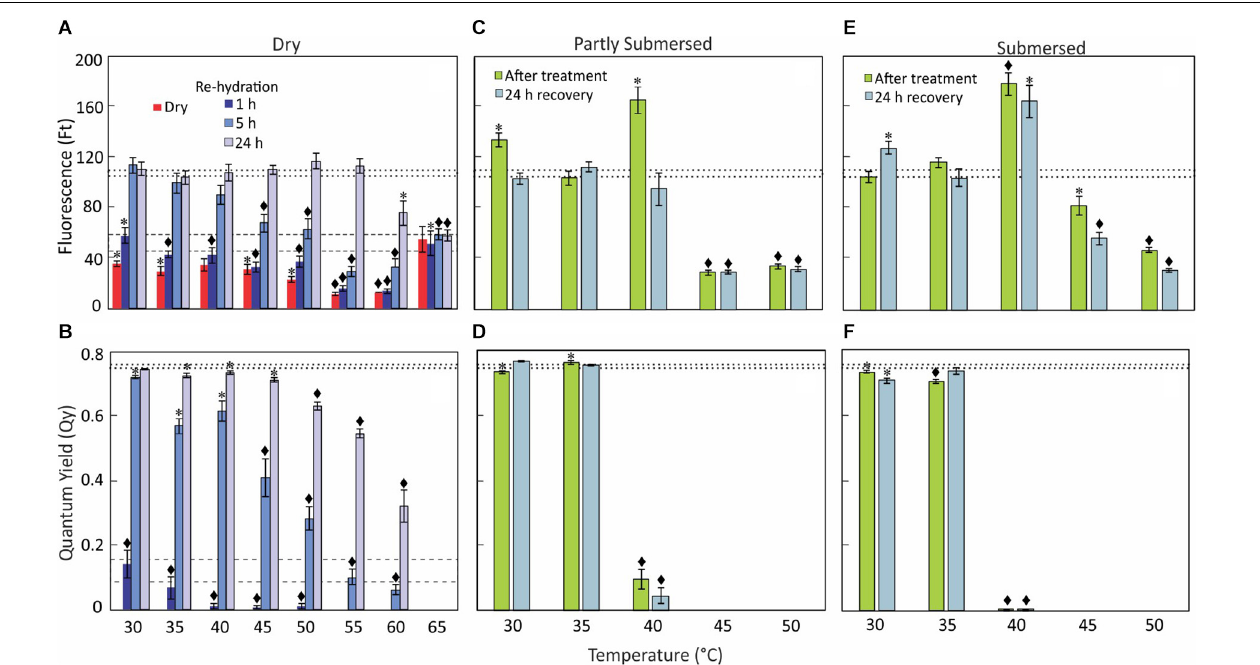
FIGURE 3 | Chlorophyll fluorescence, F t (A,C,E) and Q y (B,D,F) data of dry, re-hydrated, partially, and fully submersed Pleopeltis fronds after 24 h exposure to different temperatures. Control values ± SE @ 25 ◦ C for F t and Q y of dry fronds are indicated by dashed lines (A,B) and for rehydrated fronds by dotted lines (A–F) . The F t and Q y of heat-treated, dry samples are compared with 25 ◦ C dry samples (A,B) ; dried fronds did not show measurable Q y values regardless of temperature. Re-hydrated and hydrated samples are compared with 25 ◦ C fresh samples (C–F) . Significant differences between controls and treatments are indicated by * ( P ≤ 0.05) and (cid:7) ( P ≤ 0.001); means ± SE, n = 6.